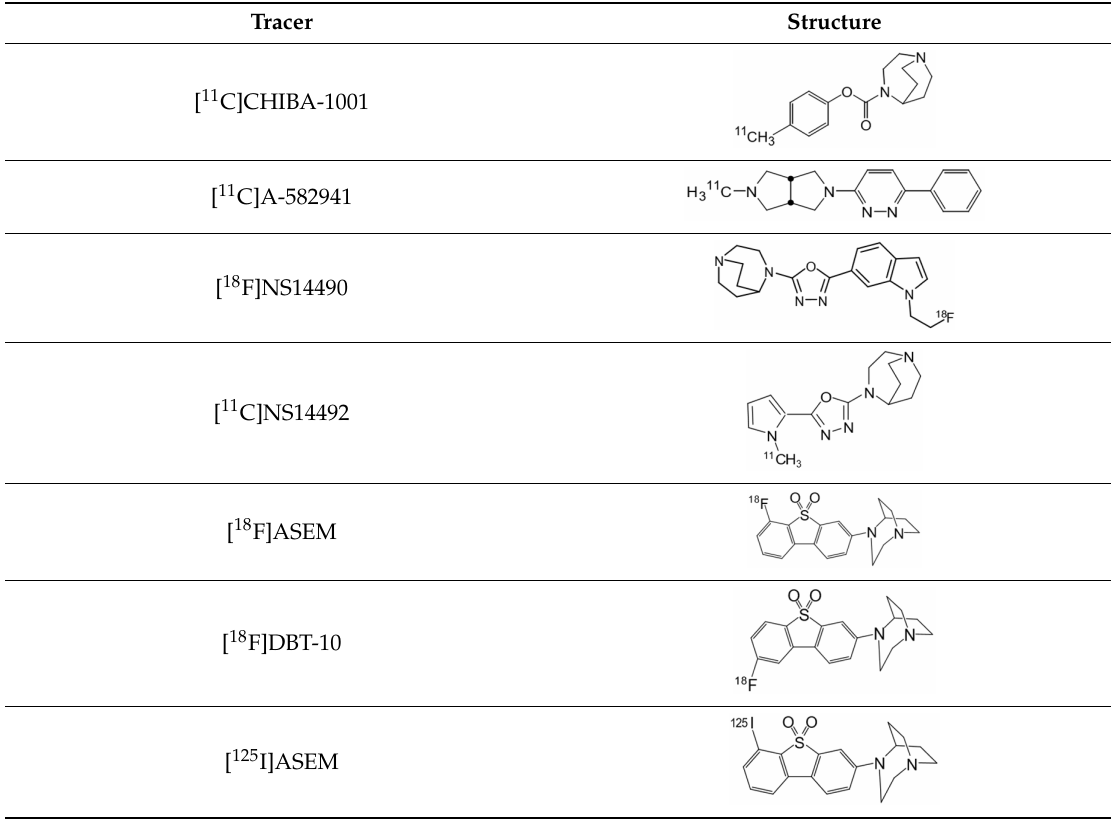
Table 1. Common α 7 nAChR ligands and their structure, previously evaluated as